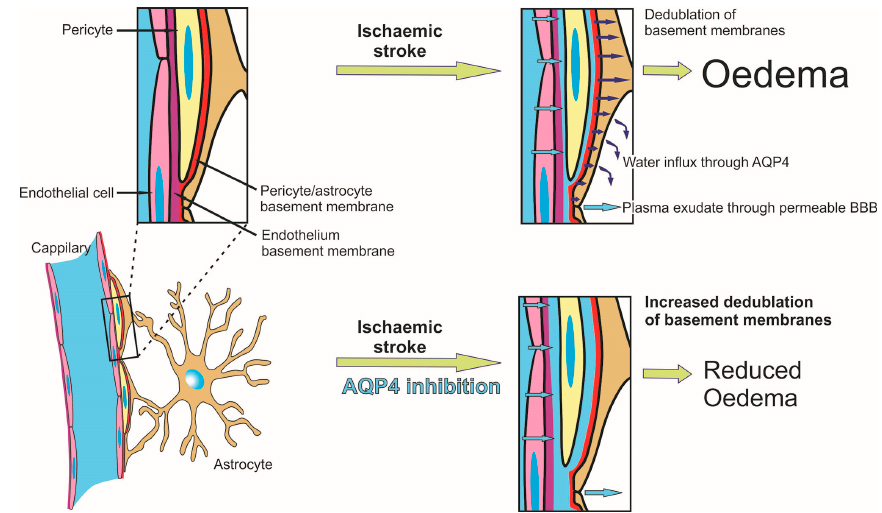
Figure 8. Overview of the mechanism driving reduced oedema and stasis in the paravascular interstitial drainage pathway following aquaporin-4 inhibition in ischemic tissue. Following ischemia, hypoxic endothelial cells lose their tight junctions and increase their permeability for serum, which infiltrates and splits vascular basement membranes, and finally infiltrates through/between the astrocytes into the parenchyma. As the mechanism of water transport at the level of the pericyte/astrocyte basement membrane is mainly dependent on AQP4, this influx is significantly reduced after its inhibition, leading to reduced water infiltration into the parenchyma, and consecutive further splitting of the basement membranes.